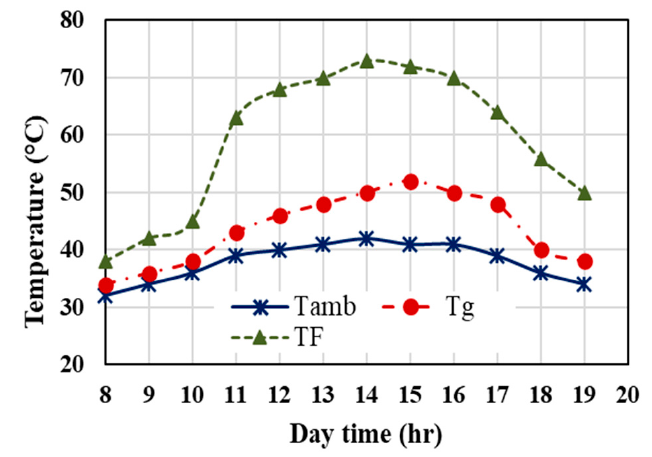
Figure 7. Temperature variation during the day (23 June 2020) and the abbreviations in the figure are as follows: T amb = ambient temperature, T g = glass temperature, and T F = feed temperature.